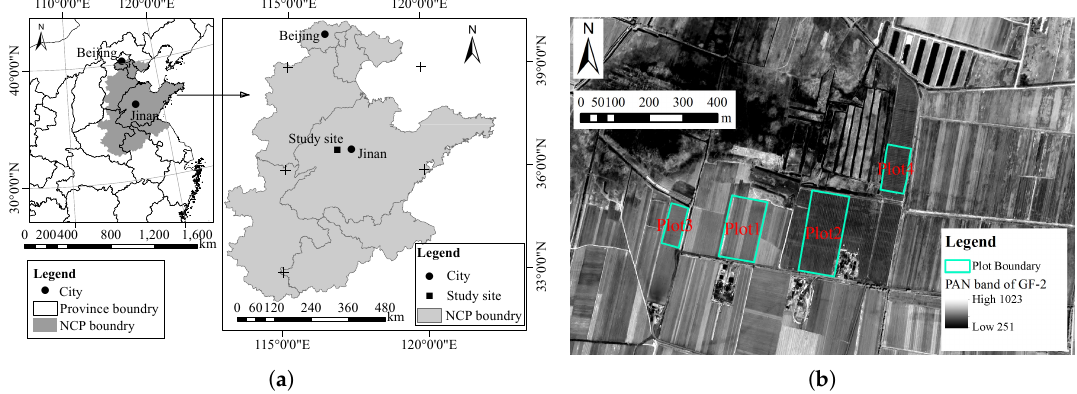
Figure 4. ( a ) location of North China Plain (NCP) and study site; ( b ) location of four plots with a 32-bit panchromatic image from the GF-2 satellite (spatial resolution: 0.83 m) as background.